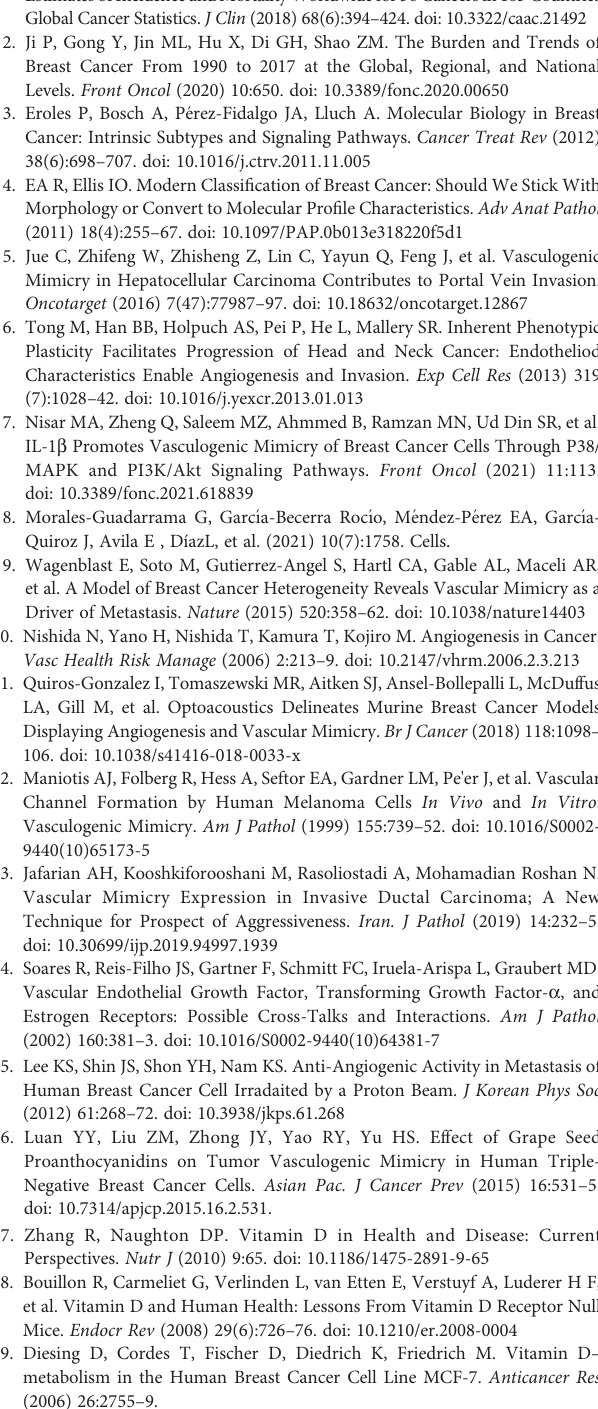
Supplementary Figure 1 | Images of the nitrocellulose proteome pro fi ler membrane showing differences in the protein expression of Pro-VM formation mediators in the control and treated samples, (A) MCF-7 and (B) MDA-MB-231.